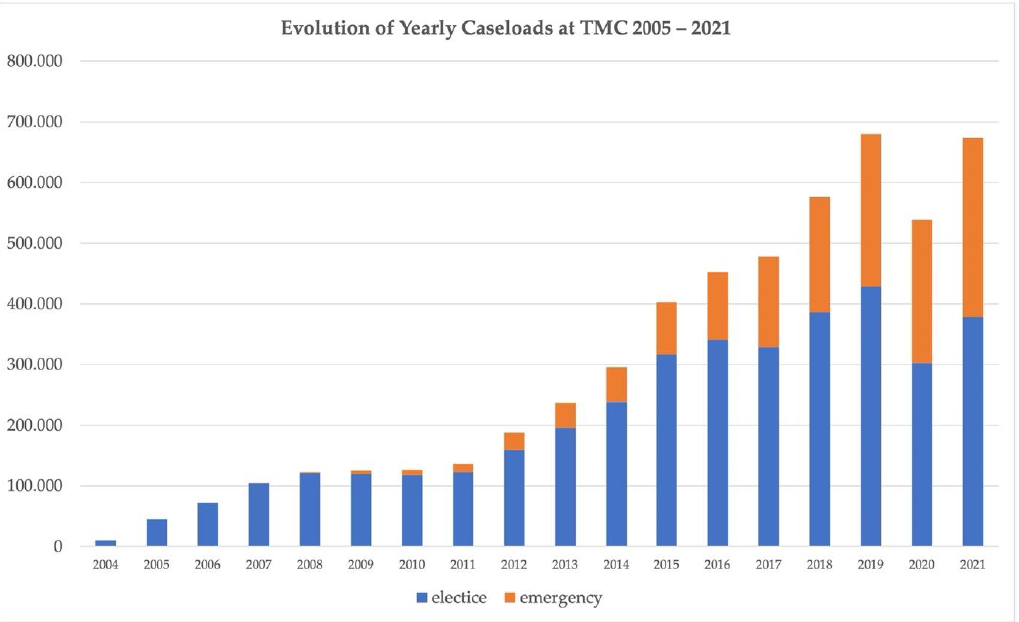
Figure 2. Evolution of caseload of elective and emergency teleradiology cases at TMC from 2005 to 2021.